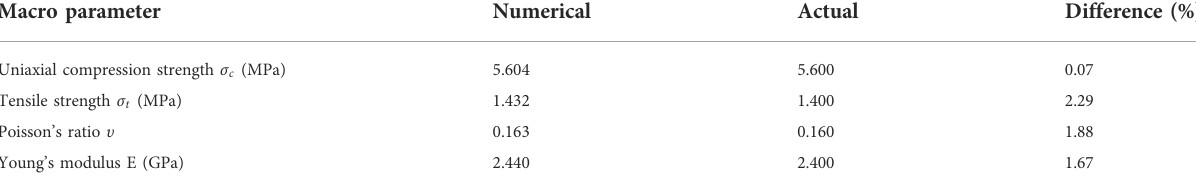
TABLE 3 Comparison of macro parameters from numerical and actual simulation. Macro parameter